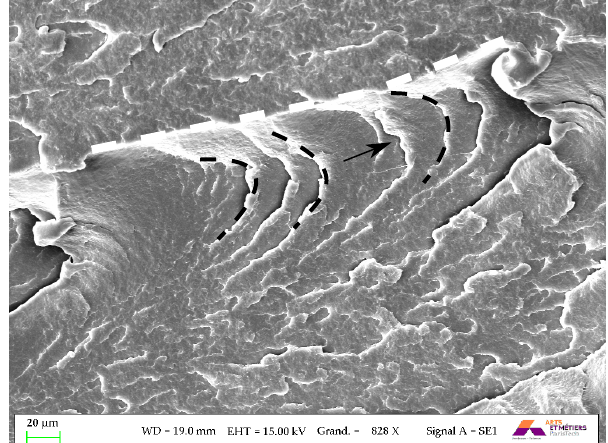
Figure 7. Observation by electron microscopy of the microcracks in the propagation zone of the fracture surface of sample B5. The arrow indicates the direction of propagation of the microcrack front. Several parabolic arrest marks of the micro-crack can be observed. The dashed line indicates the boundary between two crack planes at two di ff erent